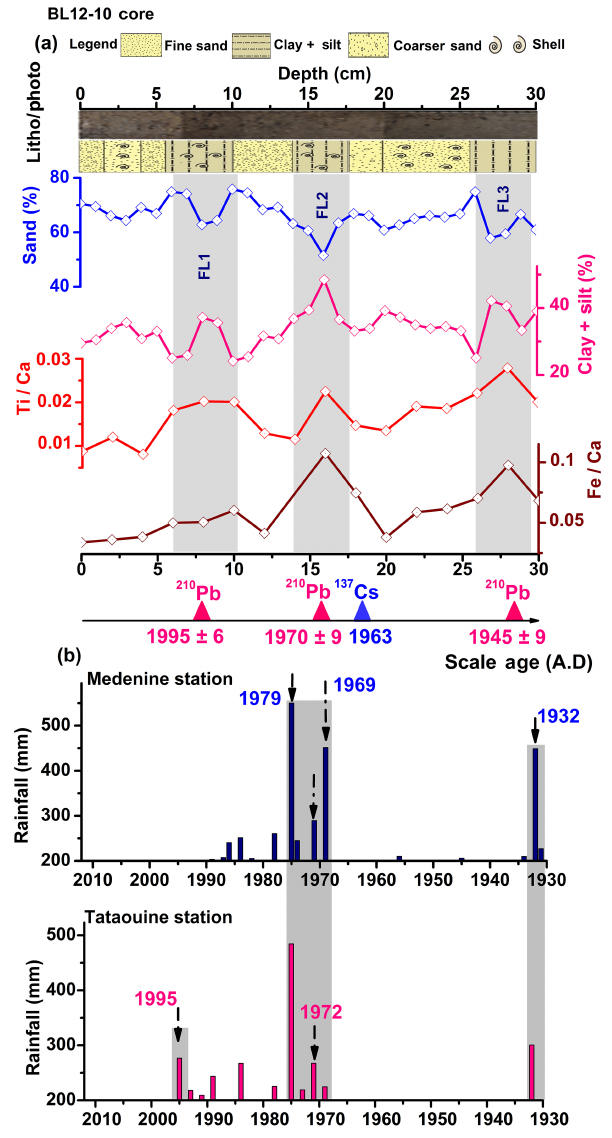
Figure 12. (a) Palaeo-flood records in the sedimentary archive of core BL12-10 based on elemental ratios of Fe / Ca and Ti / Ca and grain-size analysis (clay + silt; fraction <63µm). Triangles indi- cate the age control obtained using 210 Pb and 137 Cs along the core. Coloured areas display the three periods of floods recorded in the core (FL1, FL2 and FL3). (b) The observed rainfall record since 1932 in Medenine and Tataouine stations is also